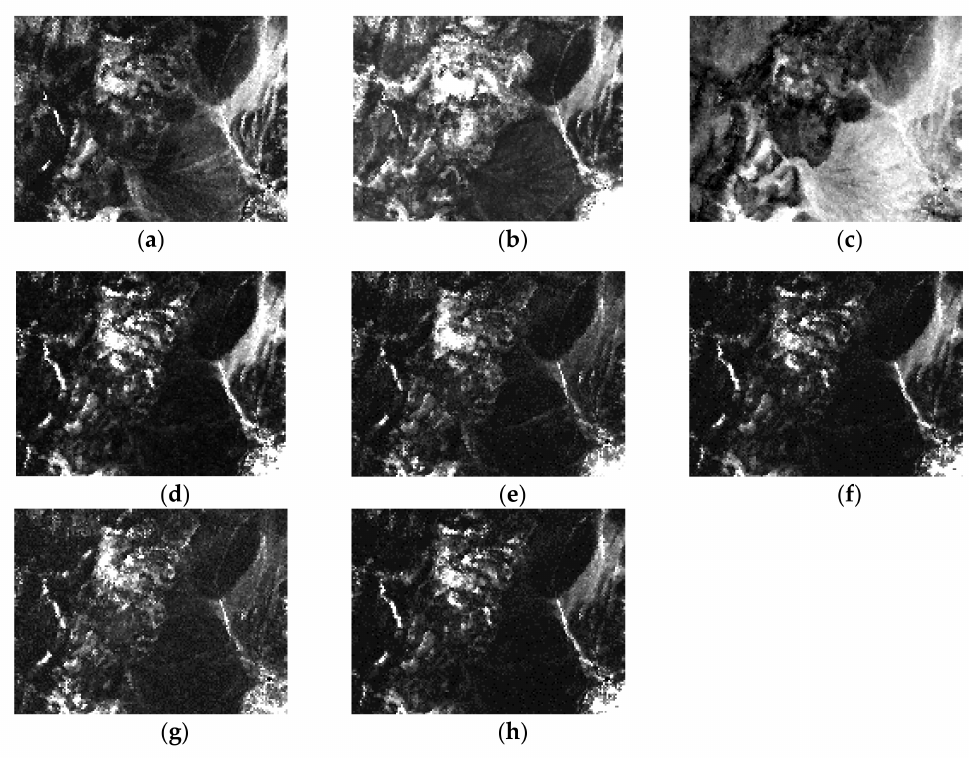
Figure 25. The unmixing RMSEs: ( a ) VCA, ( b ) N-FINDR, ( c ) SGA, ( d ) C-NMF, ( e ) MVC-NMF, ( f ) ICE,